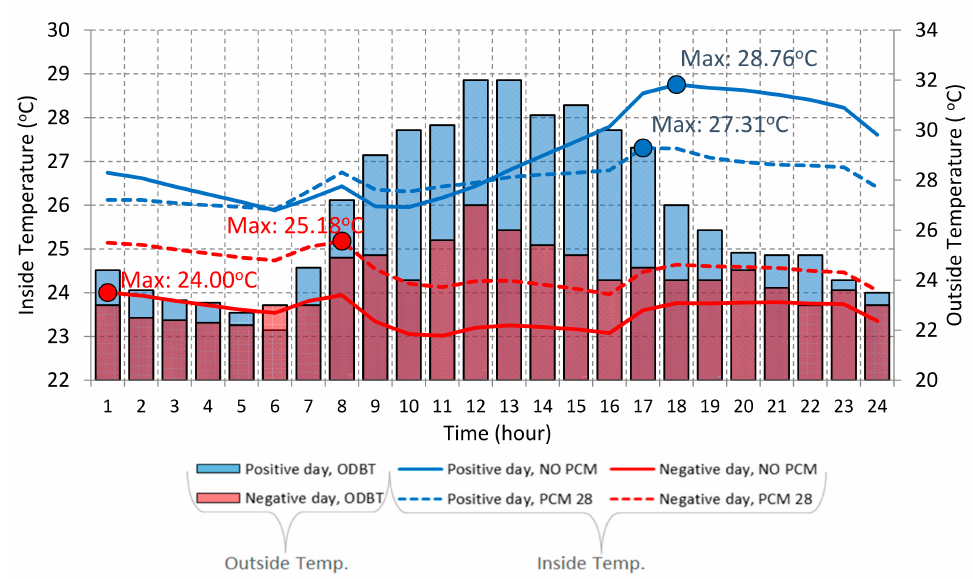
Figure 9. Inside operative temperature and outside temperature for positive and negative days for the city of